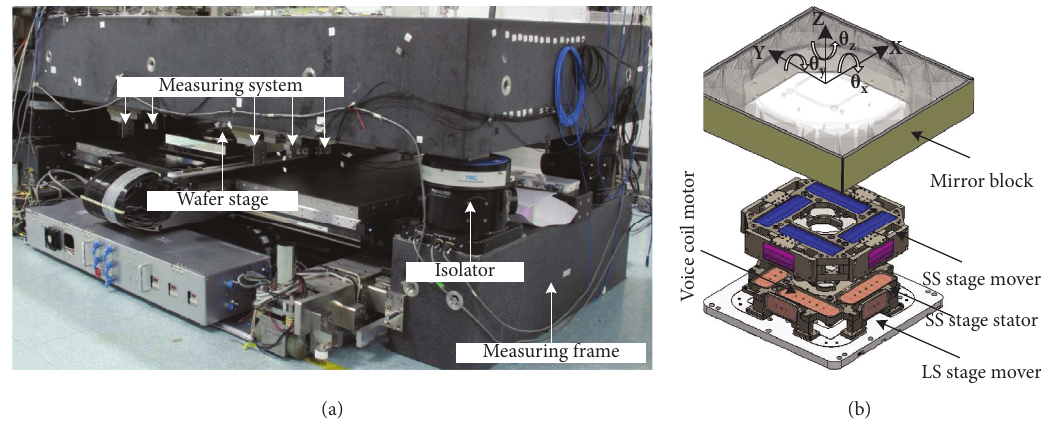
Figure 2: The experimental system of the wafer stage. (a) Real experimental wafer stage system. (b) Explosive view of wafer stage